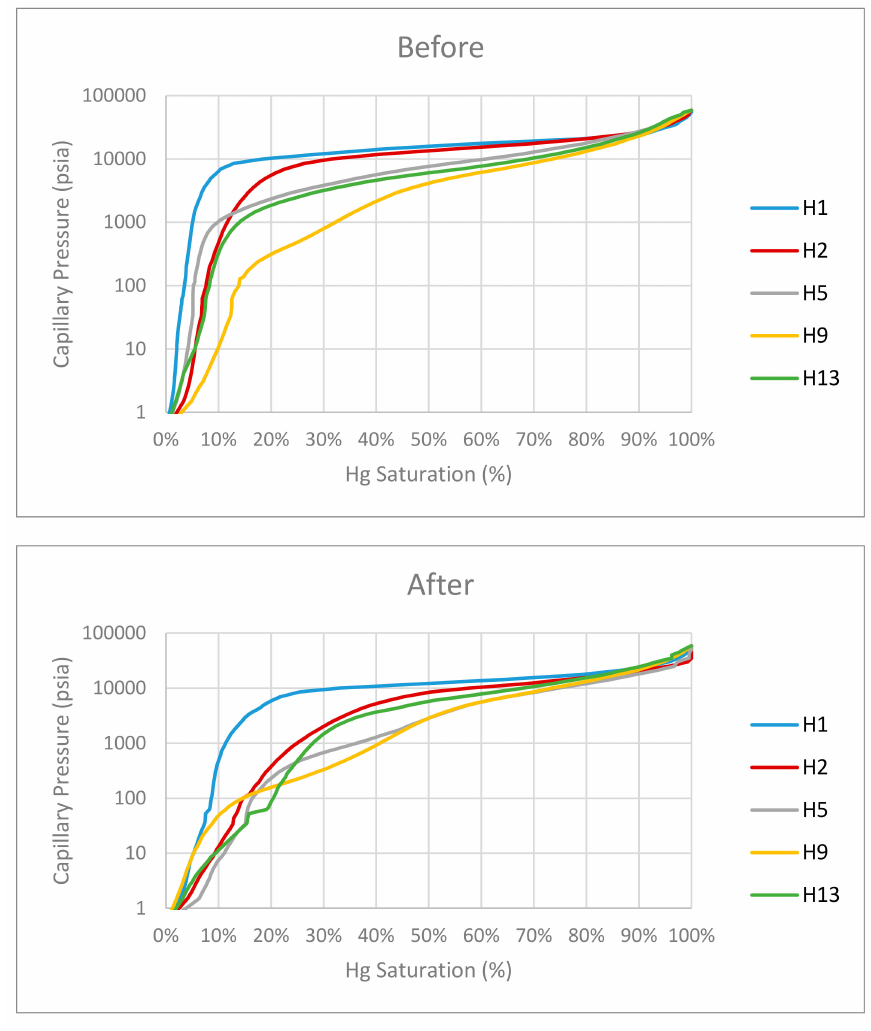
Figure 11. Capillary pressure vs Hg saturation before and after exposure. Table 5. Parameters used for the calculation of maximum CO 2 column heights retained by di ff erent shale intervals before and after exposure to scCO 2